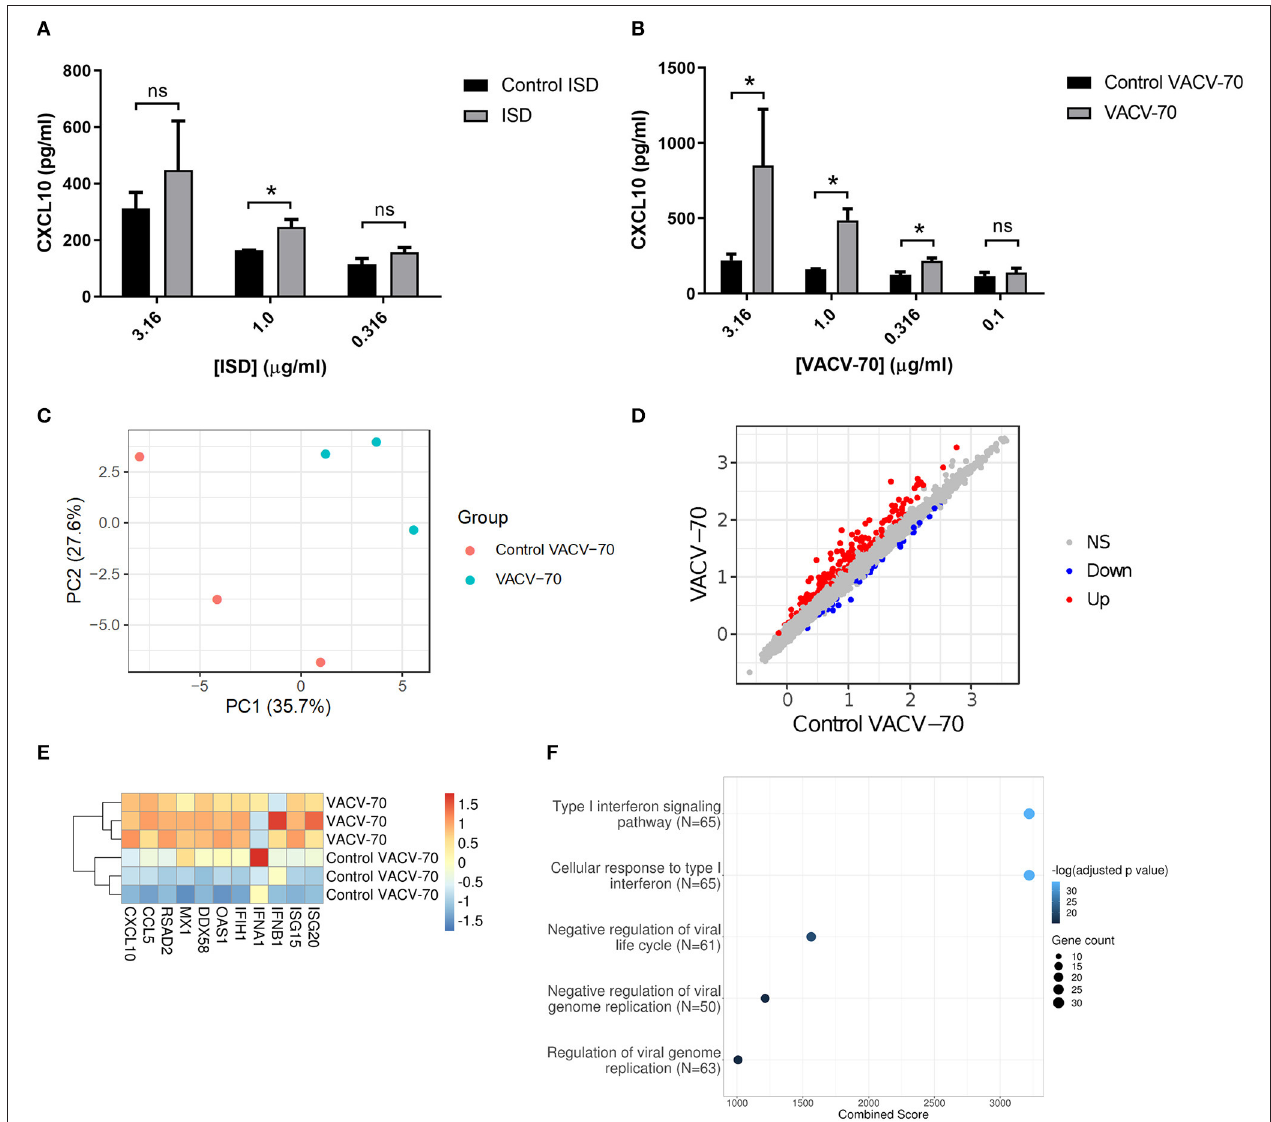
FIGURE 3 | dsDNA induced antiviral responses in HBEC-6KT in vitro. (A) Concentration-response analysis of ISD-induced CXCL10 protein production for HBEC-6KT cells. Gray bars: ISD, Black bars: control ssDNA generated from ISD. (B) Concentration-response analysis of VACV-70-induced CXCL10 protein production for HBEC-6KT cells. Gray bars: VACV-70, Black bars: control ssDNA generated from VACV-70. (C) PCA plot of microarray gene expression profiles of HBEC-6KT cells following transfection with VACV-70 or control. Red circles (control VACV-70), blue circles (VACV-70). (D) Log 2 expression data for transfection treatment with VACV-70 compared to control VACV-70. Significantly differently expressed genes are identified in blue (down − 42 genes) and red (up − 170 genes). (E) Heat map of log 2 expression data (scaled by gene) of select known antiviral for VACV-70 and control VACV-70 samples. (F) Top 5 GO Biological Processes are ranked by increasing –log 10 adjusted p- value, with number (Count) of significantly differentially expressed genes between VACV-70 and control VACV-70 contributing to the total number of genes associated with the given pathway ( N ) denoted by the size of circle. All studies n = 3; * p <